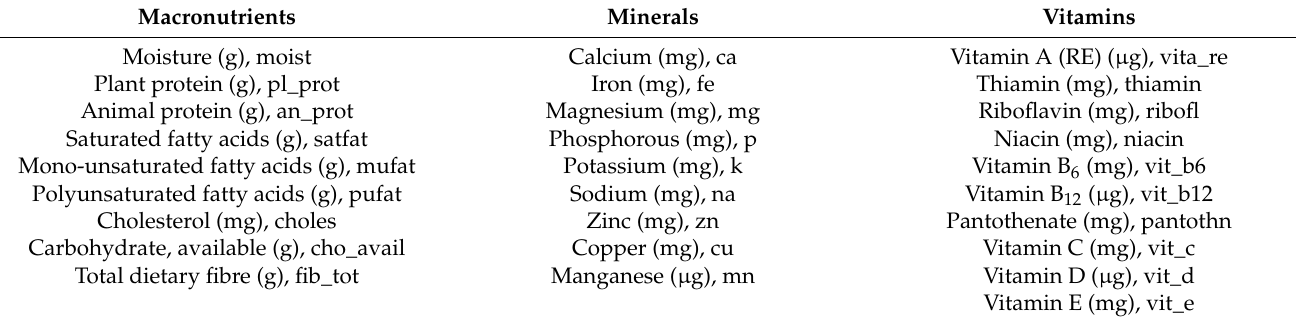
Table 2. Nutrients included in the analysis with their unit of measurement and corresponding abbreviations used in figures. Macronutrients